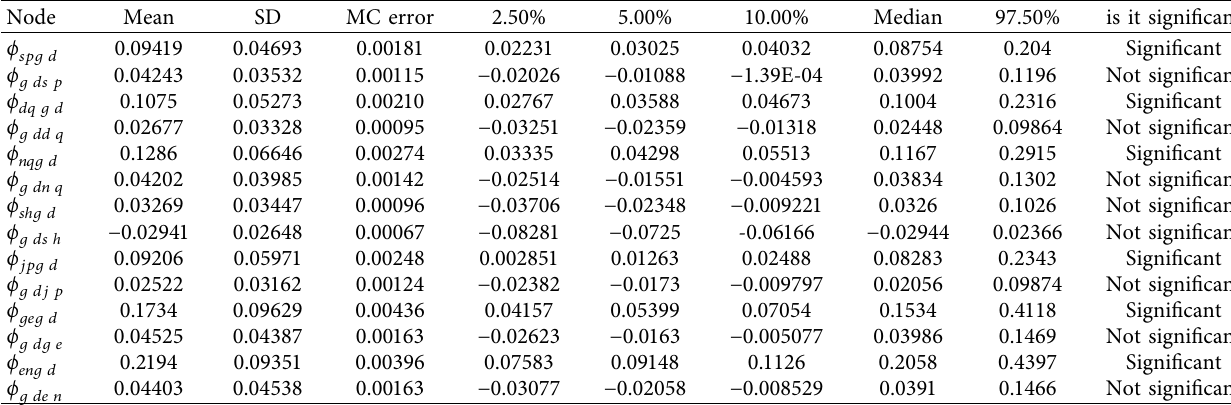
Table 6: Granger causality result between gold and stock index.